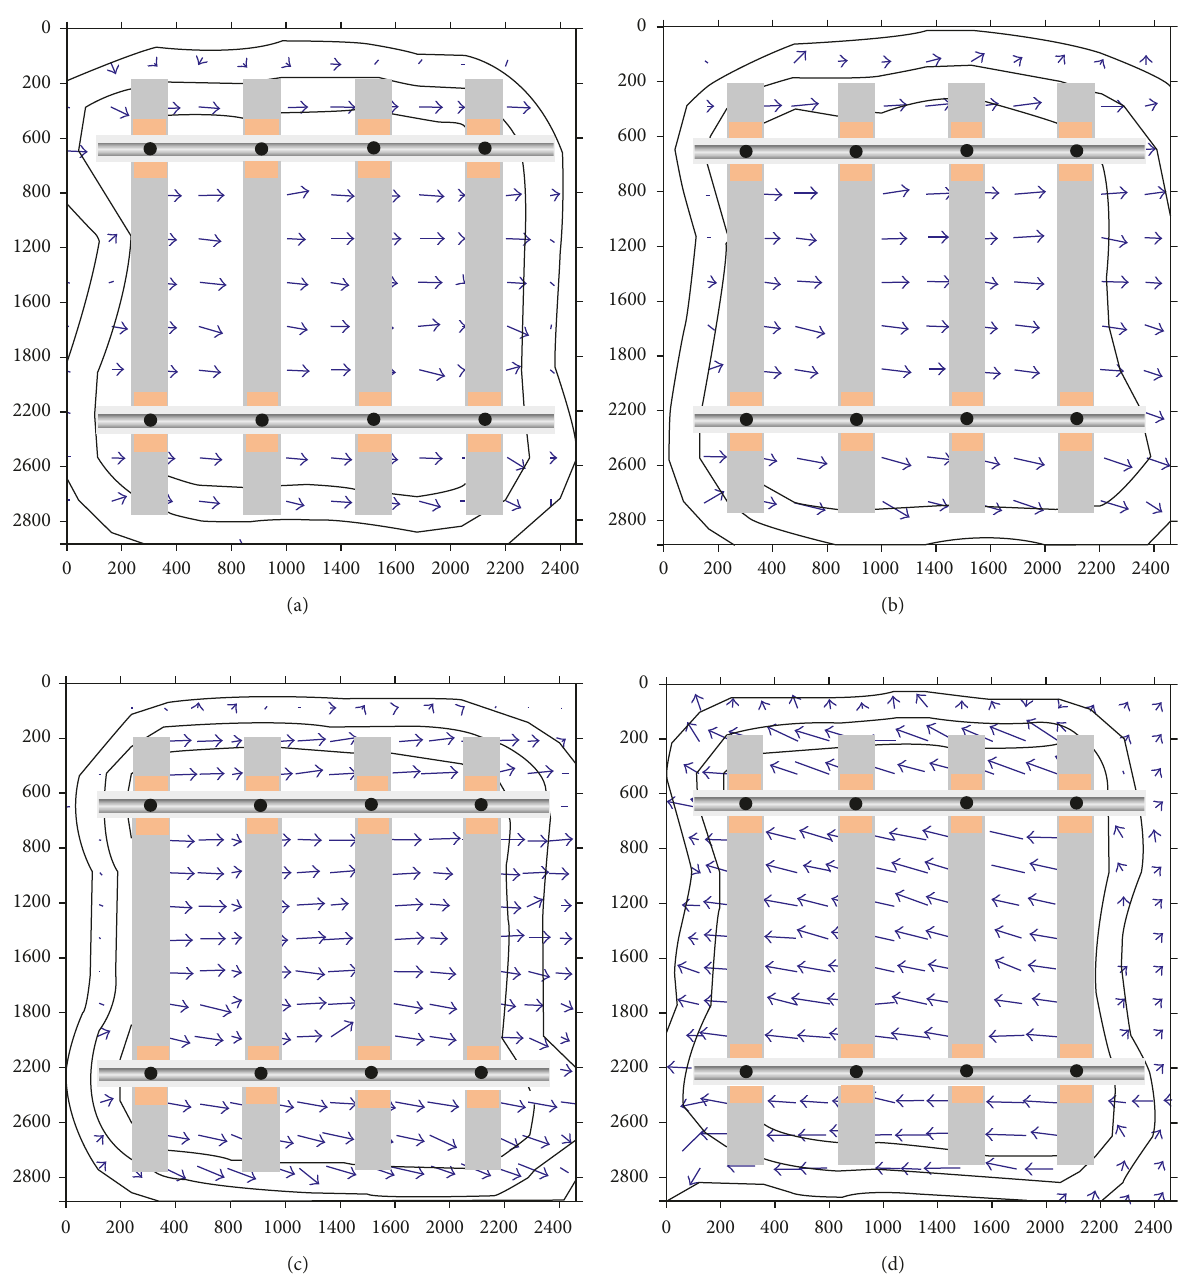
Figure 8: Motion of ballast grains under different displacement amplitudes: (a) 4mm, (b) 6mm, (c) 10mm, and (d) 20